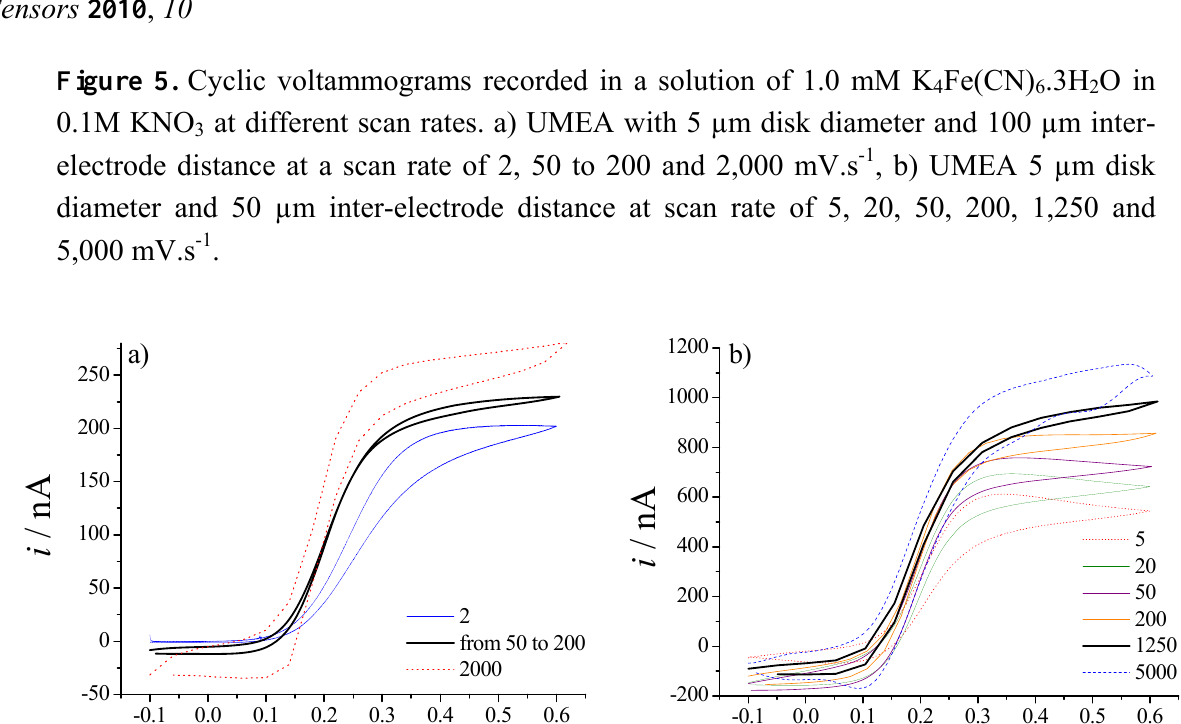
Fe(CN) .3H O in 4 6 2